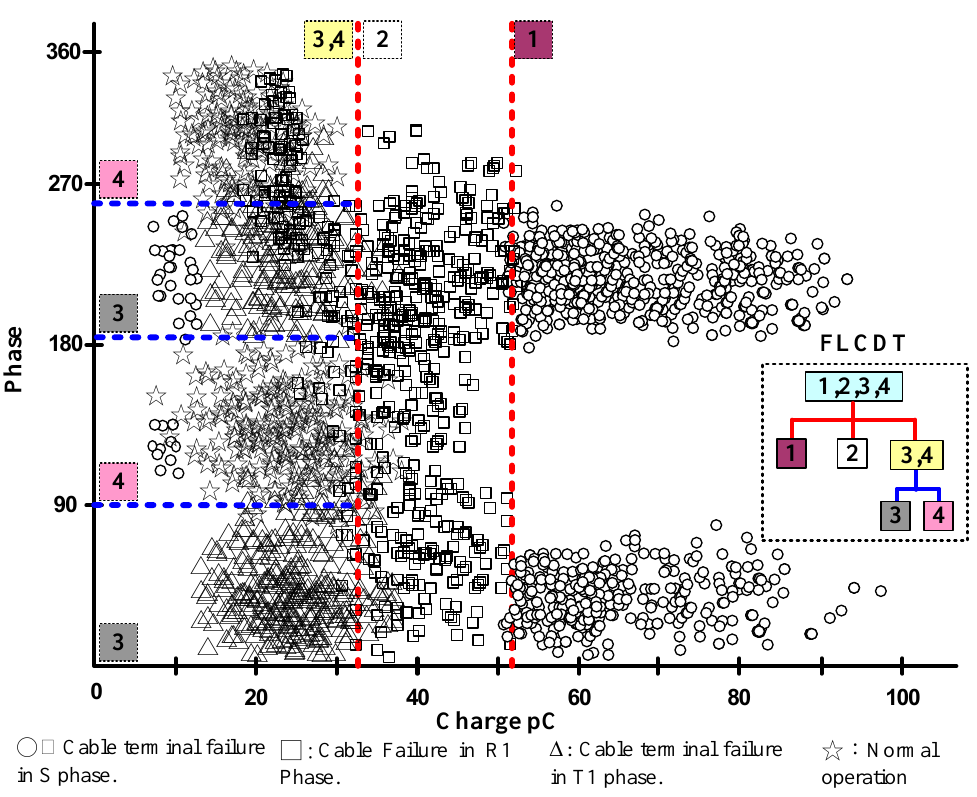
Figure 20. Distribution of the 21,092 testing feature vectors.